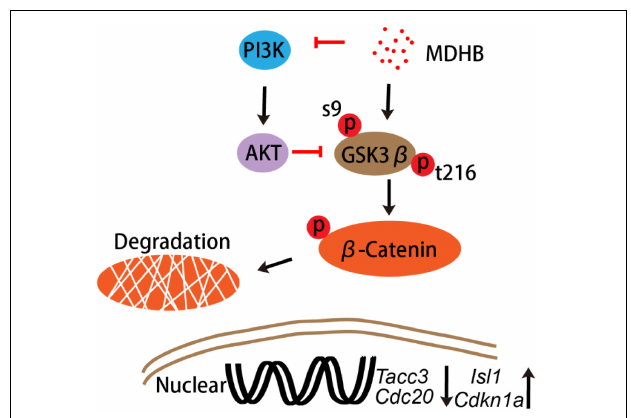
FIGURE 8 | The signal transduction pathway in MDHB-induced cholinergic neurons